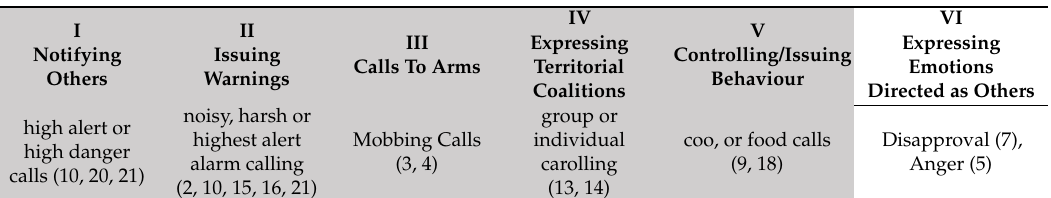
Table 2. Functional clusters in social and territorial communication. The table shows the call types that juveniles did not express (in the shaded areas (I–V). The calls they did express in VI have no shading. A cross-reference is provided between acoustic characteristics with function (using the numbering of Table